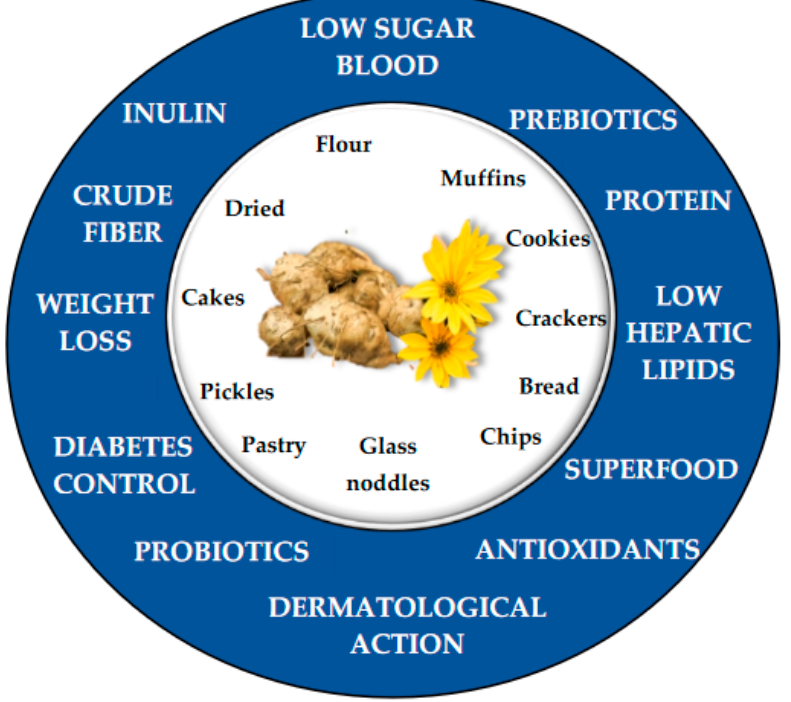
Figure 1. Summarize gastronomic preparations and human health benefits of H. tuberosus .